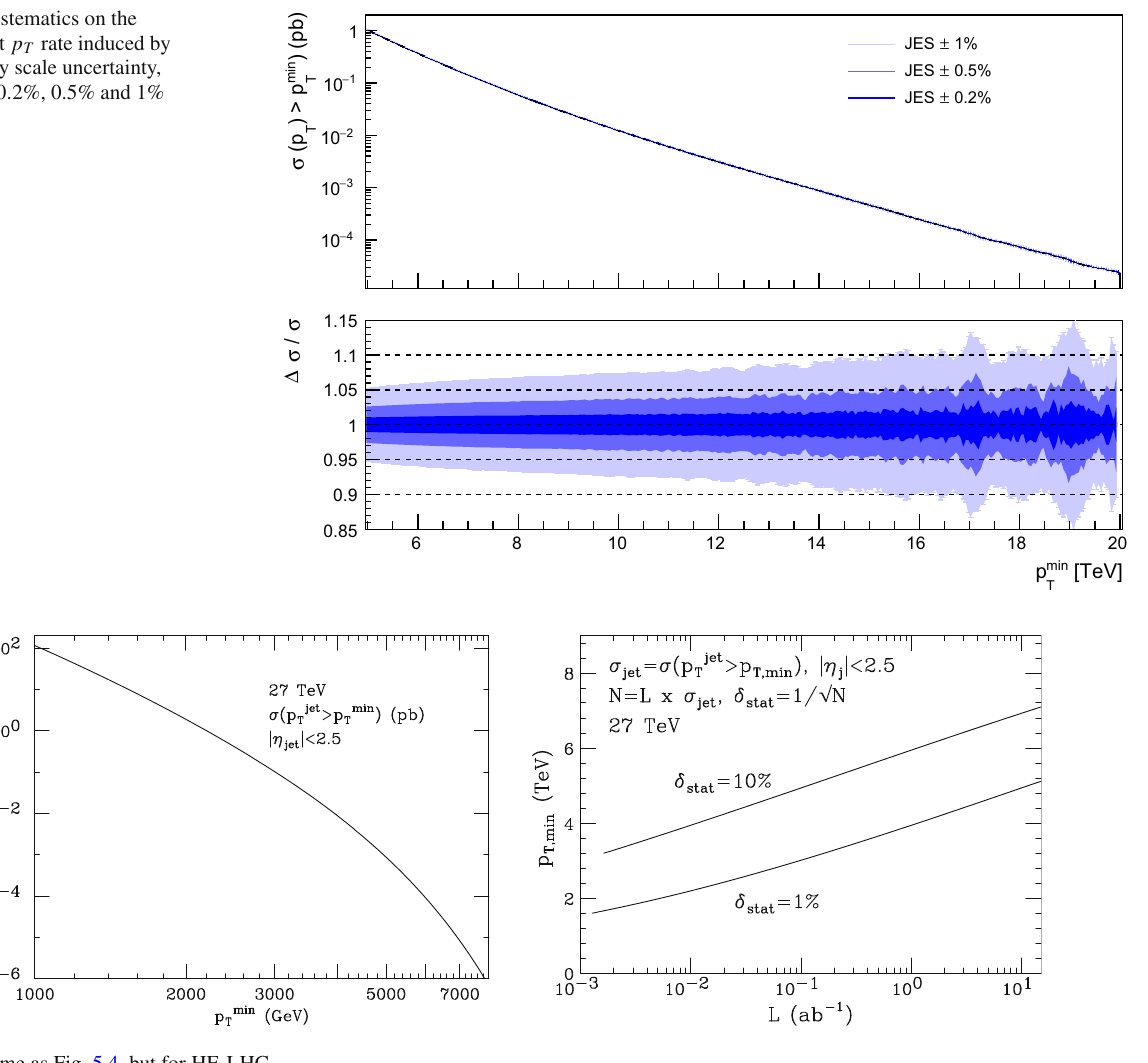
Fig. 5.7 Same as Fig. 5.4, but for HE-LHC